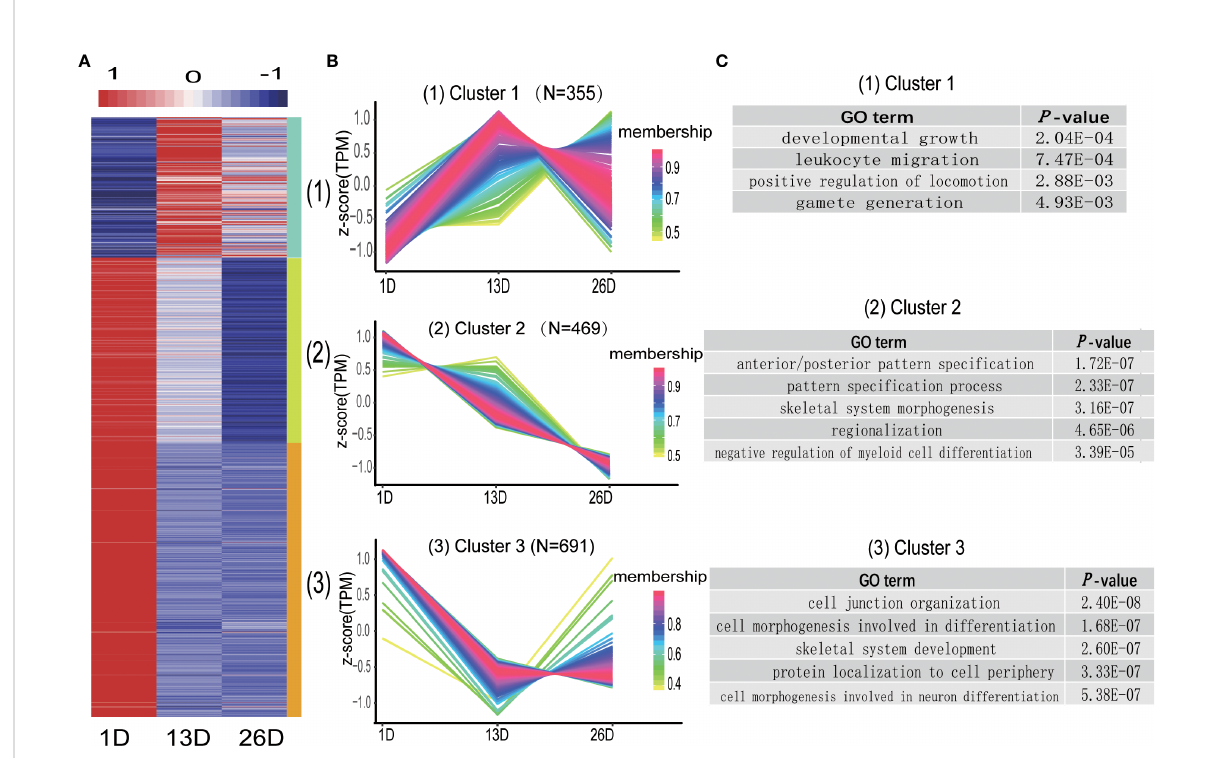
FIGURE 8 Distinct expression patterns of differentially expressed lncRNAs across the BF development stages. (A) . The heatmap shows the expression patterns of the 3 clusters. Each row represents a lncRNA. The color indicates the Z-score of normalized expression values. (B) . Cluster analysis of the DE lncRNA expression patterns across the BF development stages. Membership values indicate the goodness of fi t for lncRNAs in a particular cluster. (C) . Representative enrichment categories of target genes of DE lncRNA in different